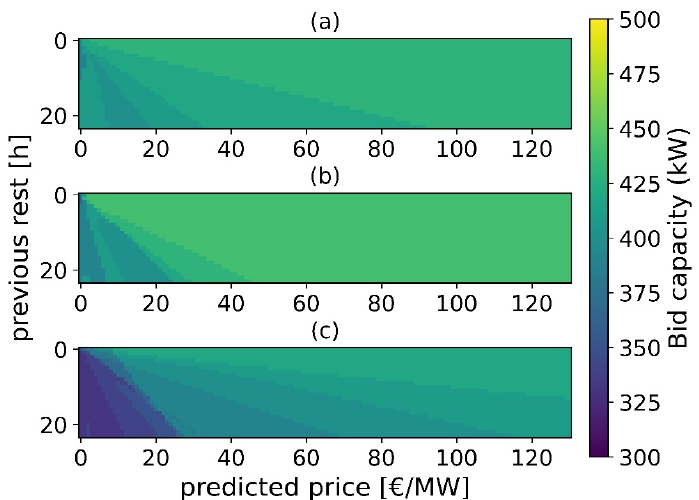
Figure 5. Action selections of three algorithms: ( a ) REINFORCE, ( b ) A2C and ( c )